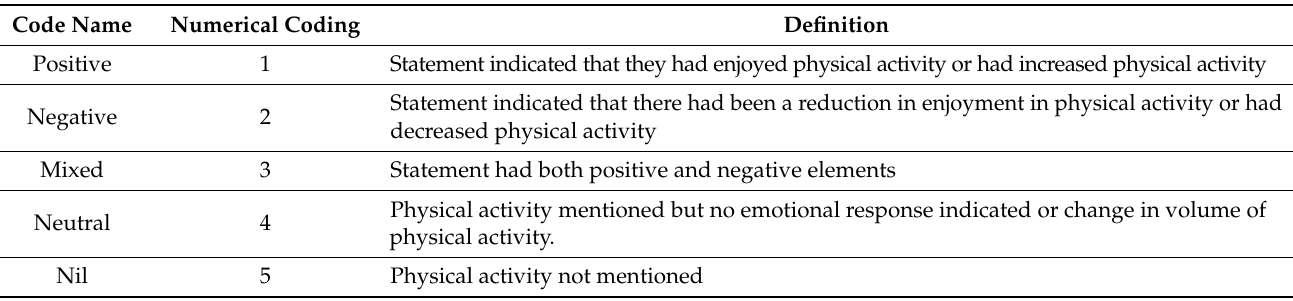
Table 2. Definition for First order